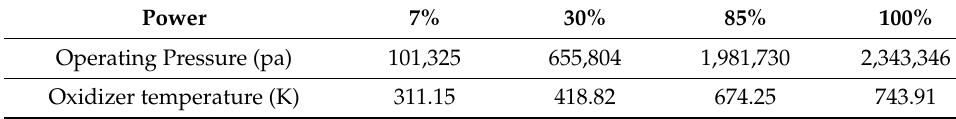
Table 3. Operating pressures and oxidizer temperatures [38].